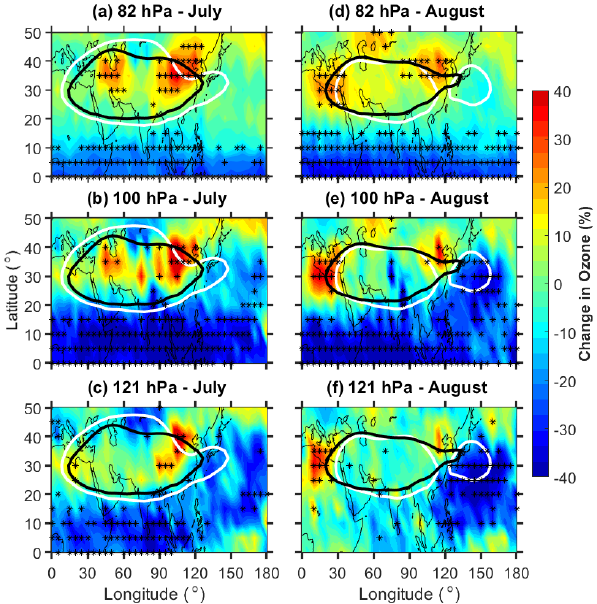
Figure 7. Ozone relative percentage change in July 2015 with respect to background climatological monthly mean observed at (a) 82hPa, (b) 100hPa, and (c) 121hPa. Subplots of (d) – (f) same as (a) – (c) but for the month of August. The white (black) color con- tour represents 16.75km geopotential height at 100hPa for the cor- responding month in 2015 (mean of 2005–2014). The star symbols (black) shown in the figure represent the anomalies greater than the ± 2 σ standard deviation of the long-term mean. The results are ob- tained from MLS